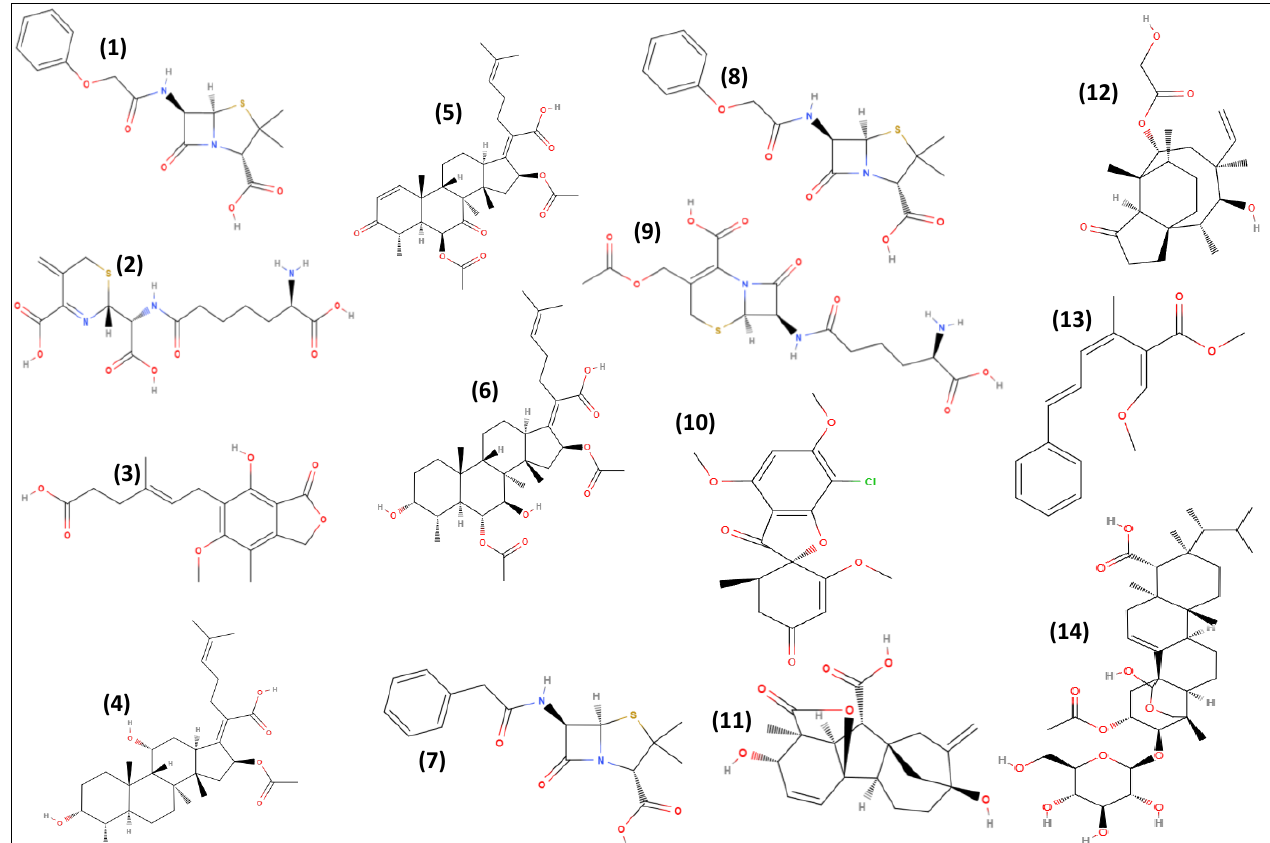
Figure 4. Examples of secondary metabolites from fungi and some of their derivatives successfully applied by pharmaceuticals and agrochemicals industries. (1) penicillin, (2) cephalosporin, (3) mycophenolic acid, (4) fusidic acid, (5) helvolic acid, (6) cephalosporin P1, (7) penicillin G, (8) penicillin V, (9) cephalosporin C, (10) griseofulvin, (11) gibberellic acid, (12) pleuromutilin, (13) strobilurins A, and (14) oudemansins. Structures were obtained from https://molview.org/ (accessed on 2 No- vember 2022).